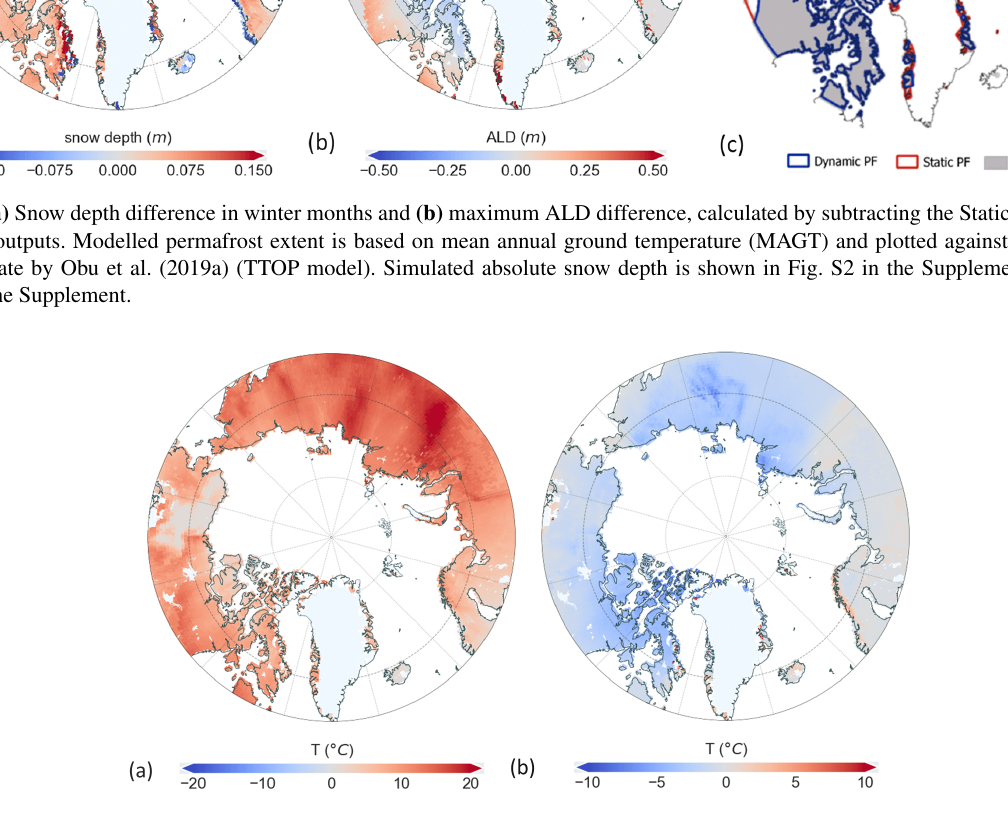
Figure 7. Near-surface soil temperature (25cm depth) difference between the Dynamic and Static simulations, for winter (a) and summer (b) seasons. Differences are calculated by subtracting the Static from Dynamic simulation outputs. The absolute simulated soil temperatures using the two snow schemes are shown in the Supplement in Fig.